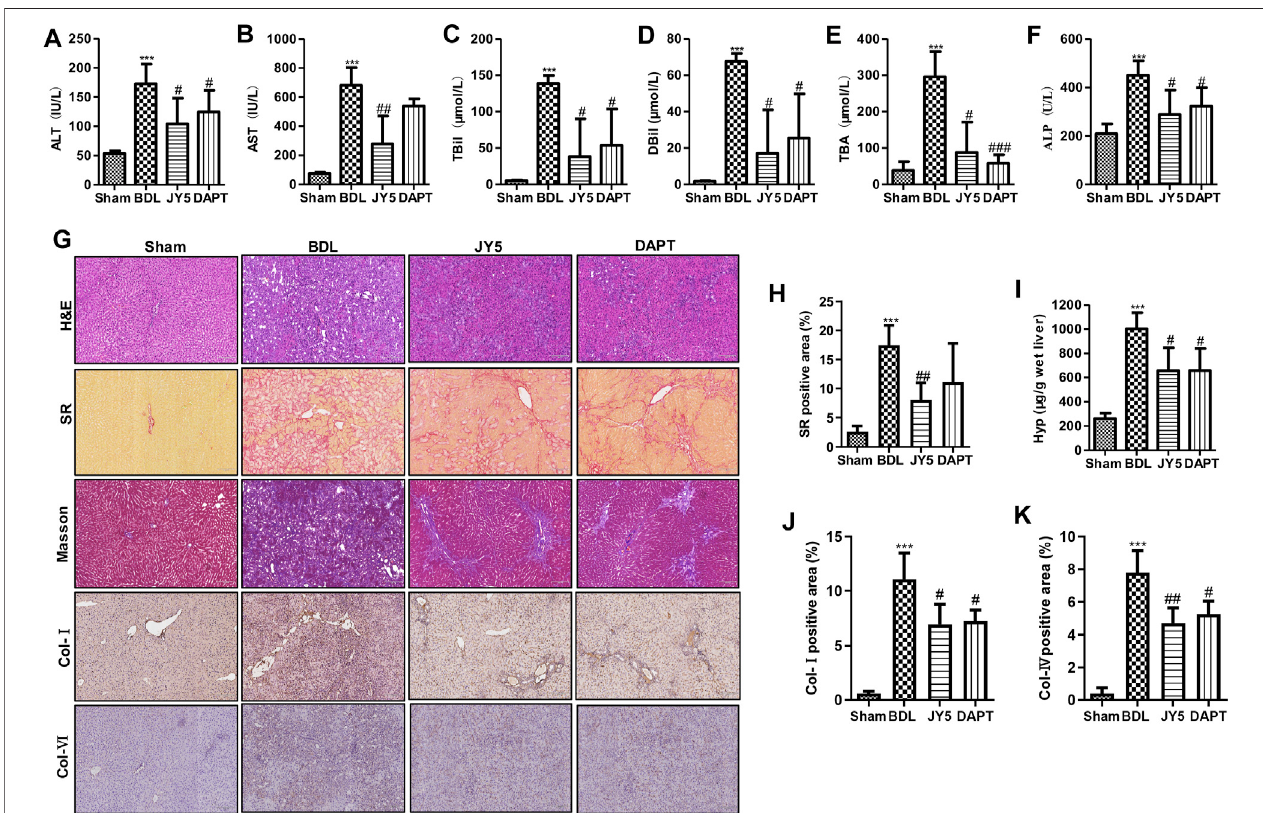
FIGURE 4 | JY5 signi fi cantly alleviates hepatic in fl ammatory injury and collagen deposition in BDL-induced rat liver fi brosis. The levels of serum ALT (A) , AST (B) , TBil (C) , DBil (D ), TBA (E) , and ALP (F) were measured in each group. (G) H&E staining (100 × ), SR staining (100 × ), Masson staining (100 × ) and IHC for Col-I and Col-IV (100 × ) staining, and semi-quantitative analysis (H) of collagen disposition (%) in SR-stained liver sections. (I) Hyp content in wet liver tissue was detected by alkaline hydrolysis. Quantitative analysis of immunohistochemical staining for Col-I (J) and Col-IV (K) . *** p < 0.001 vs the sham group, # p < 0.05, ## p < 0.01 vs the BDL